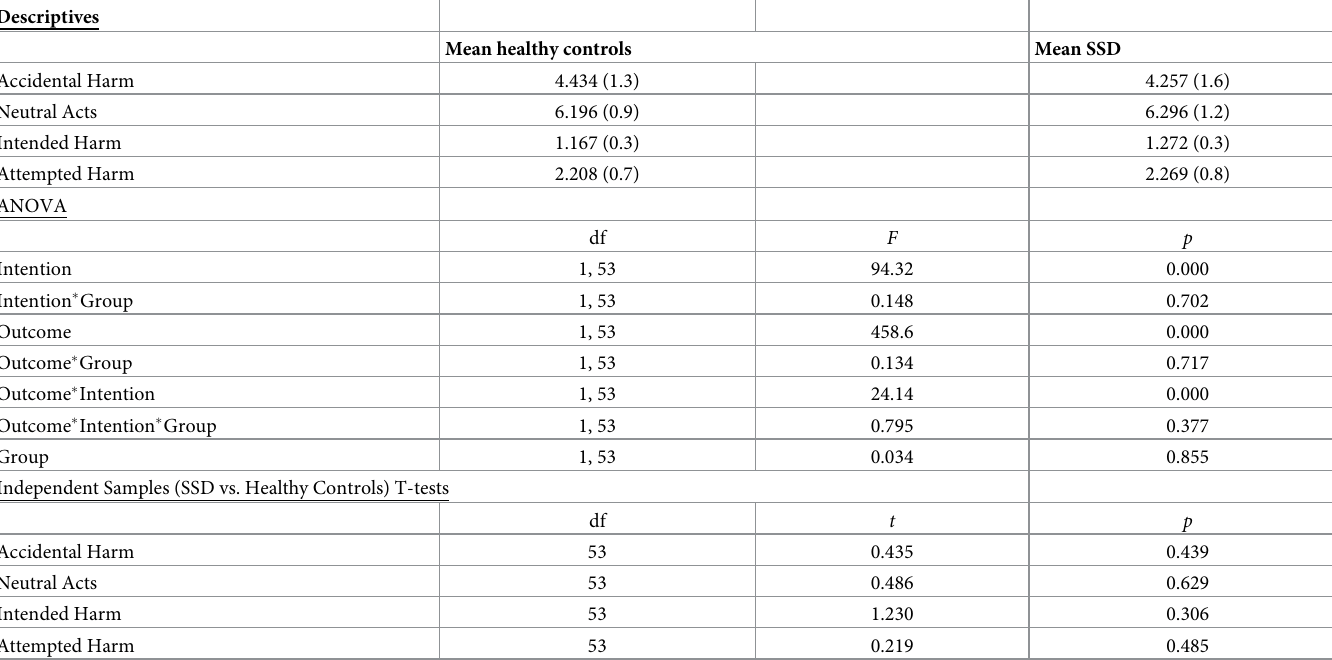
Table 2. Descriptives, ANOVA and T-test output